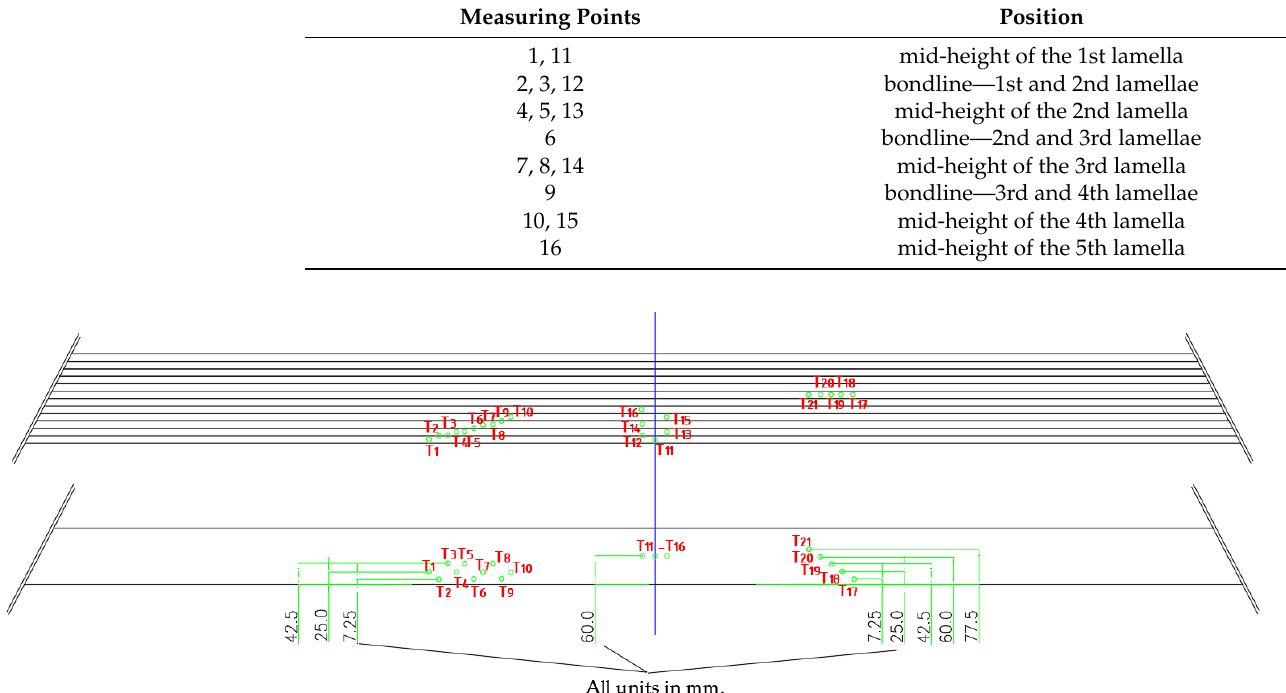
Table 3. Measuring points—thermocouple layout.